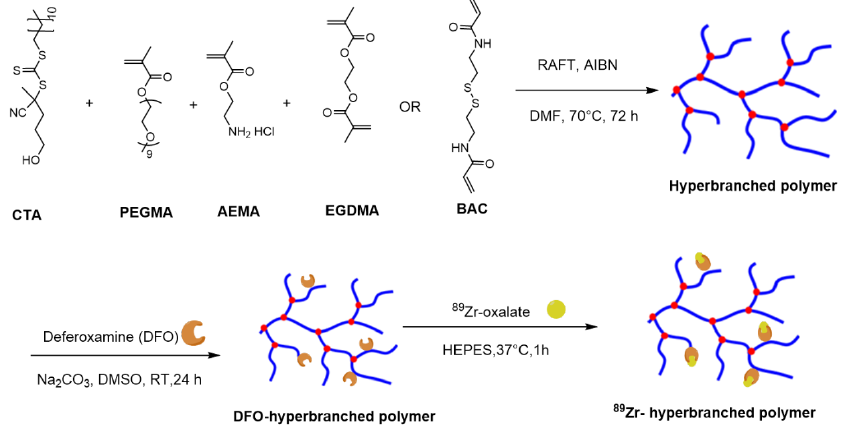
Figure 1. Schematic representation of typical approaches to synthesise non-cleavable and cleavable